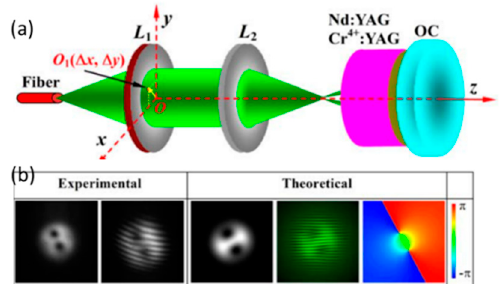
Figure 6. Dual-vortex passive Q-switched microchip laser. ( a ) Experimental setup and ( b ) experi- mental and theoretical model results.